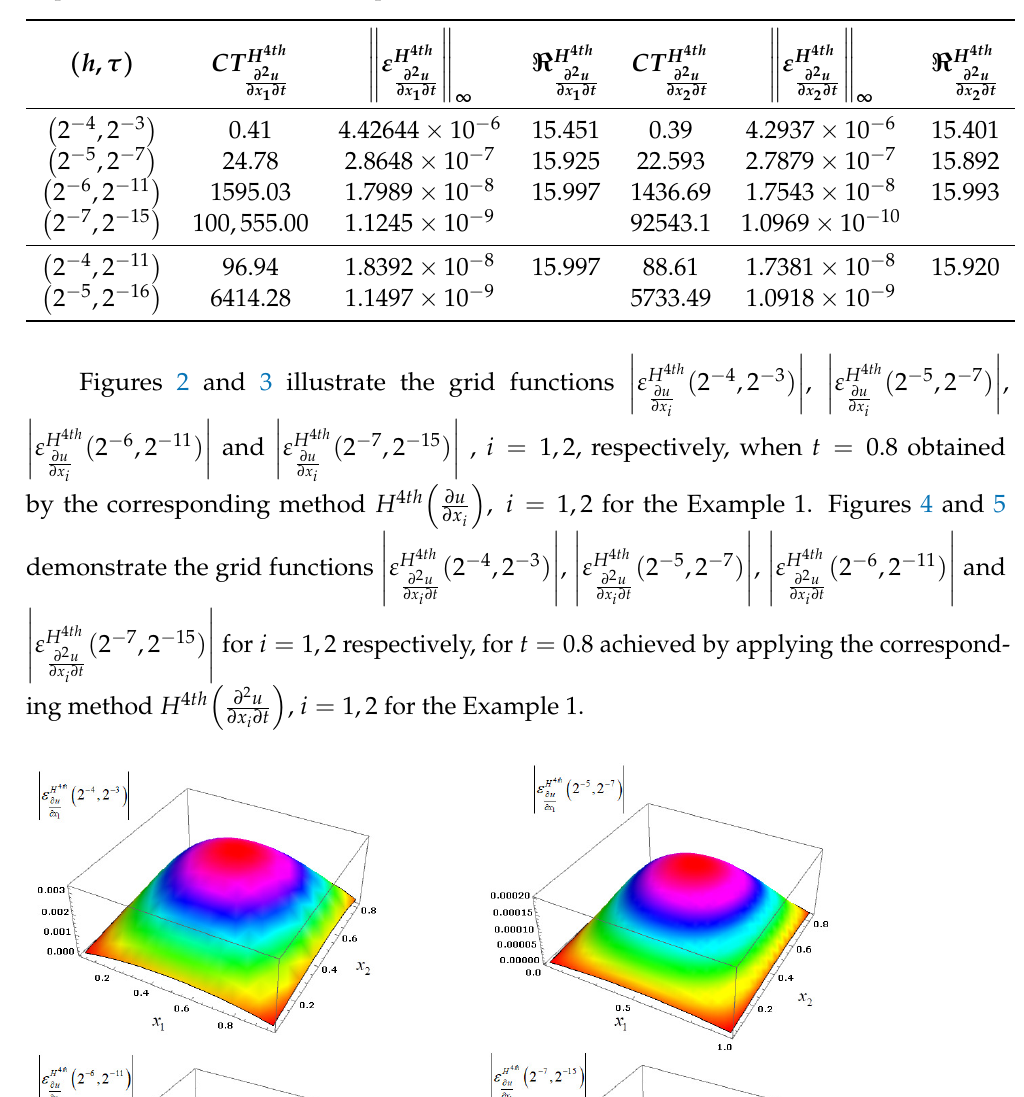
Table 3. CT H 4 th